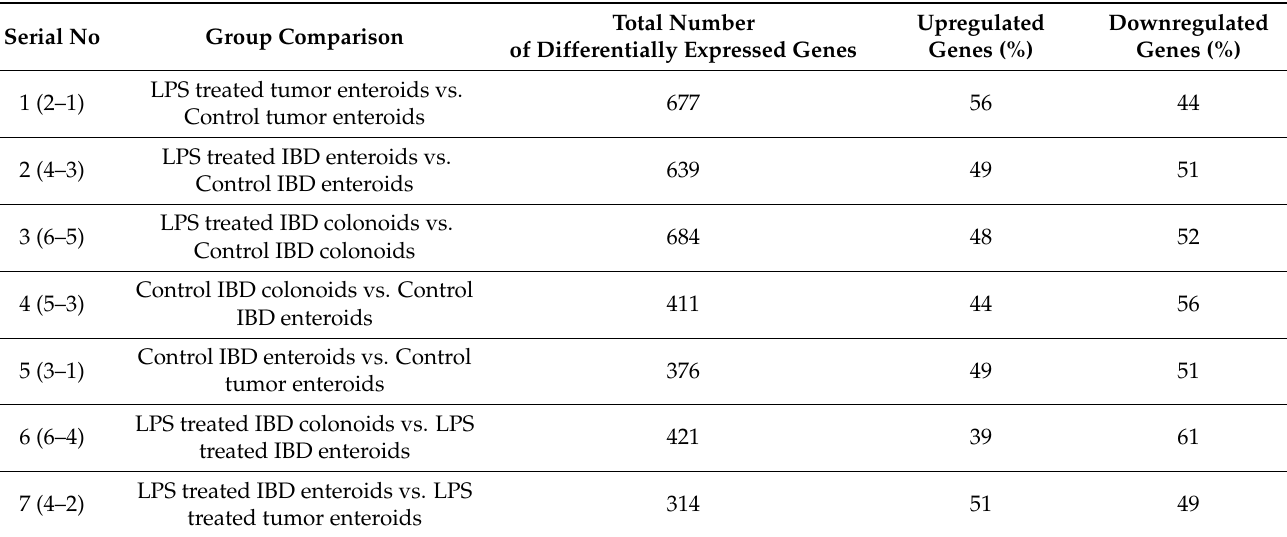
Table 3. The differentially expressed genes within the enteroid and colonoid